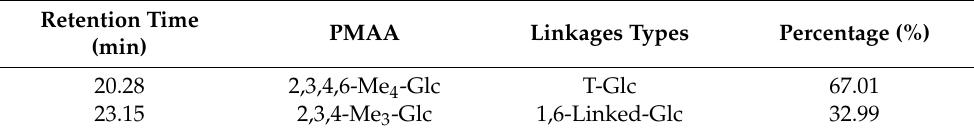
Table 3. GC-MS date for methylation analysis of